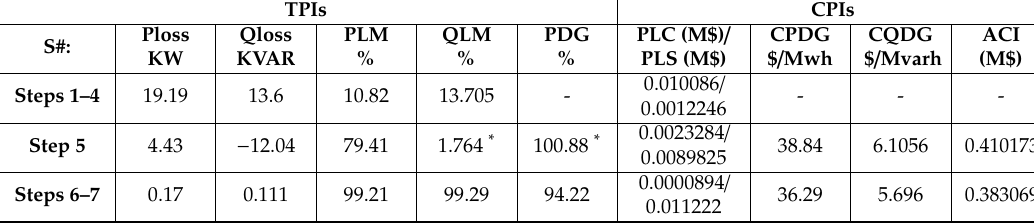
Table A4. Step 8 for TPI and CPI evaluation with the computation